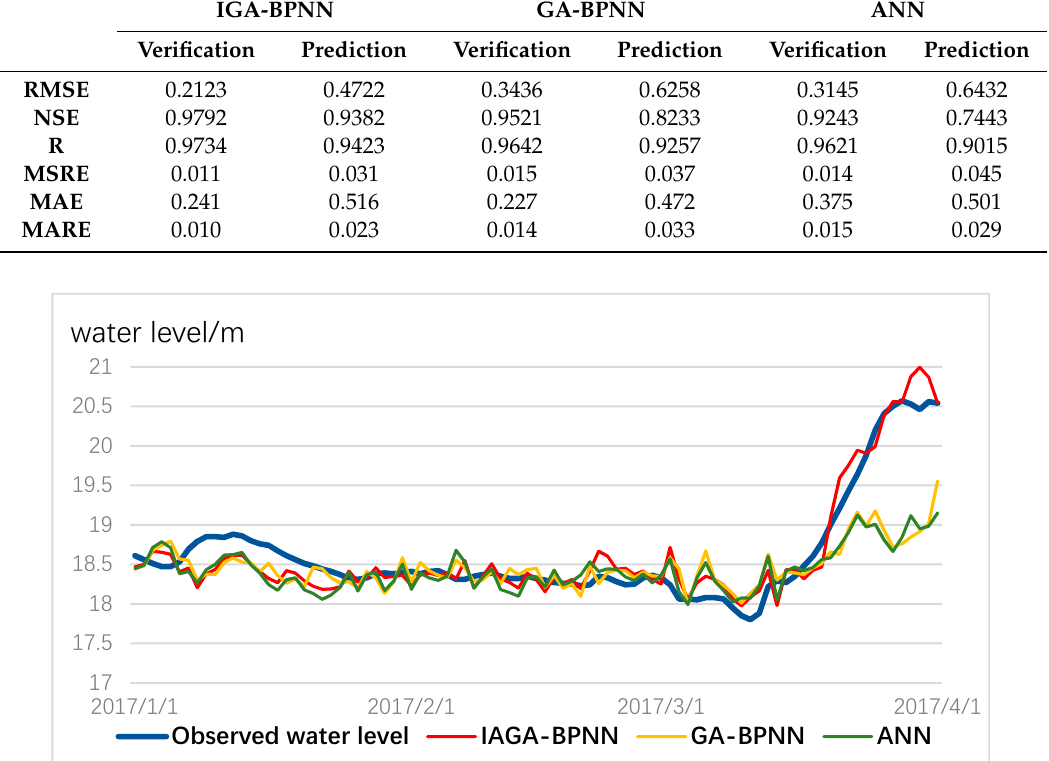
Figure 8. Comparison results for the three models for water-level prediction from January to March 2017.